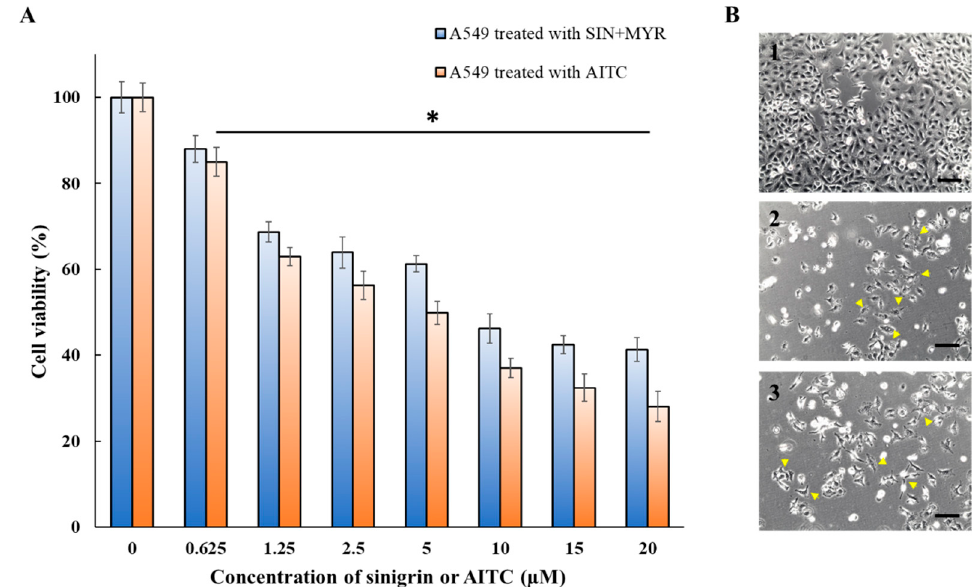
Figure 6. ( A ) Cell viability of biotinylated A549 cells after treatment with AITC, SIN+MYR for 48 h, as measured with the MTT assay; ( B ) phase-contrast images of biotinylated A549 cells after 48 h: ( B1 ) control (i.e., DMSO treated); ( B2 ) AITC treated (20 µM); ( B3 ) SIN+MYR treated. Yellow arrowheads indicate cell morphological changes probably due to apoptosis (scale bar = 100 µm). * Denotes p < 0.05 in comparison to the control (i.e., 0 µM).